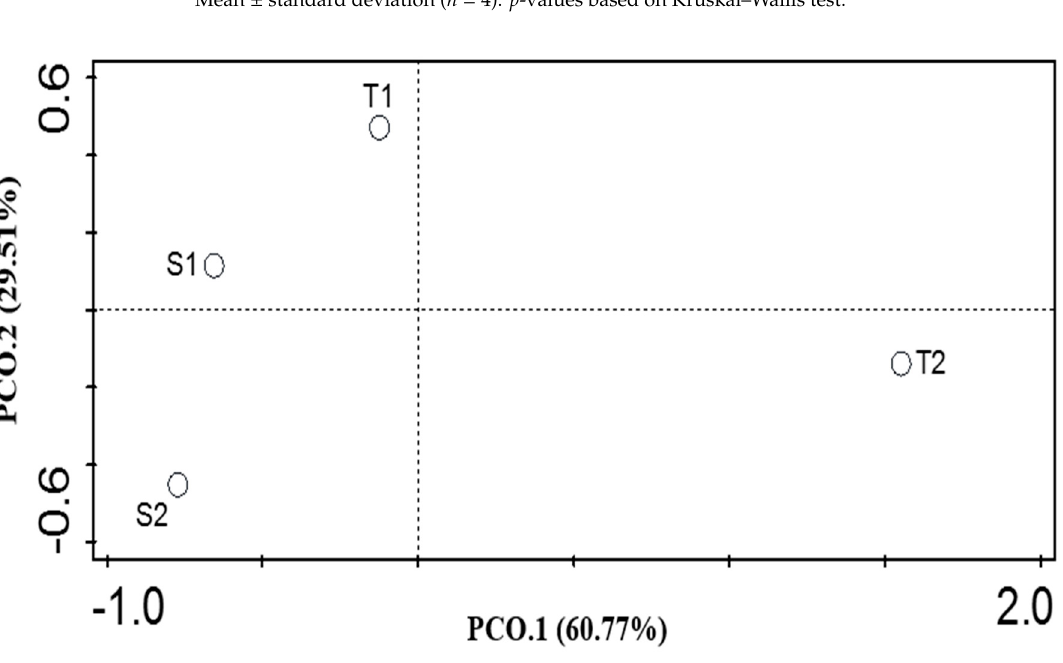
Figure 5. Principal coordinate analysis (PCoA) for functional categories at Subsystem level 1 obtained from termite mound soils and surrounding soil samples.